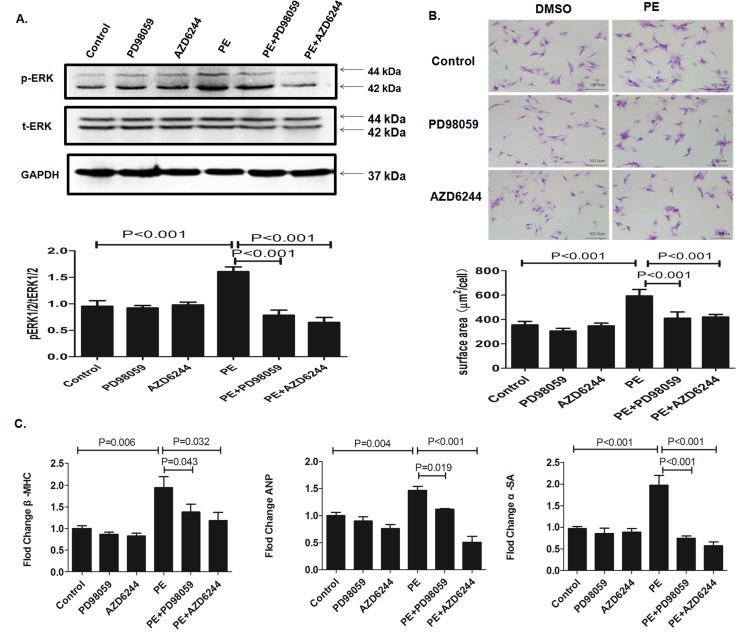
Selumetinib inhibits ERK1/2 activation upon stress and cardiac hypertrophy in NRCs.(A). Representative immunoblots using antibodies against phosphorylated ERK1/2 (pERK1/2) and total ERK1/2 (tERK1/2) to probe proteins extracted from NRCs for indicated treatments. The bar graph shows the means ± SEM signals of the pERK/tERK (relative expression from immunoblots of n = 5). (B). Representative micrographs of cultured NRCs for indicated treatments. The bar graph shows the means ± SEM of the mean cellular area (n = 3, each time, 90 cells were randomly selected and measured). (C). Bar graphs indicate the expression levels of β-MHC, ANP and α-SMA in NRCs for indicated treatments (n = 5).